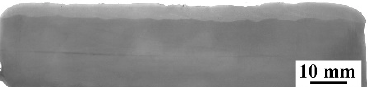
Figure 7. An example view of a cross-section of the layer made by an Omnia electrode in the air, with etching using Nital 4%.